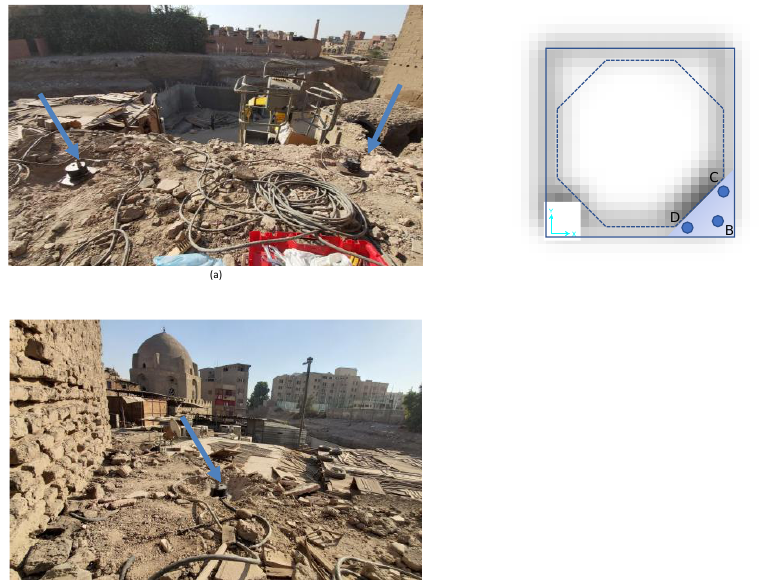
Figure 8. Test setup after installation. ( a ) Sensor “B” (Left) and sensor “D” (Right) and ( b ) Sensor “C” (note: the panel on the top right-hand of the figure is the arrangement of installed setup, indicating sensor locations).